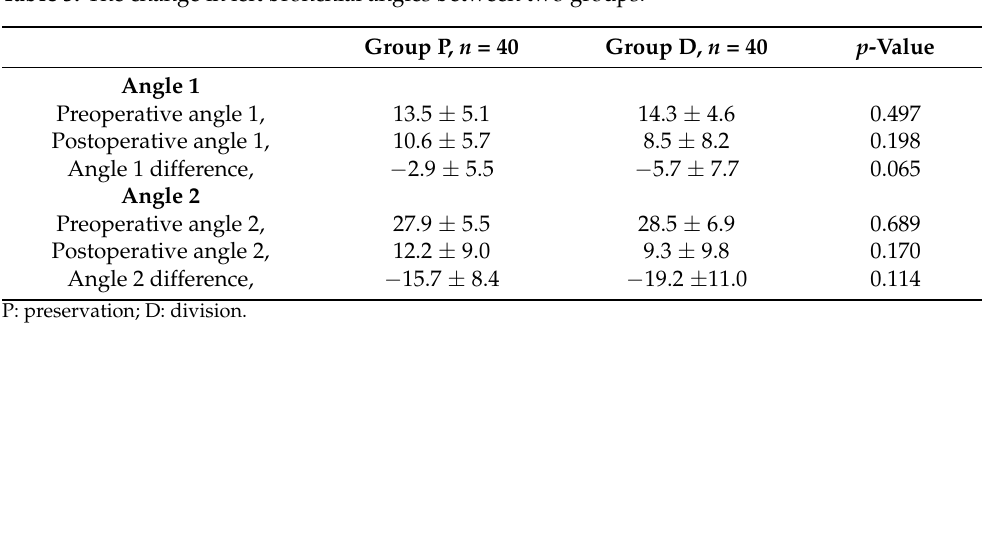
Table 3. The change in left bronchial angles between two